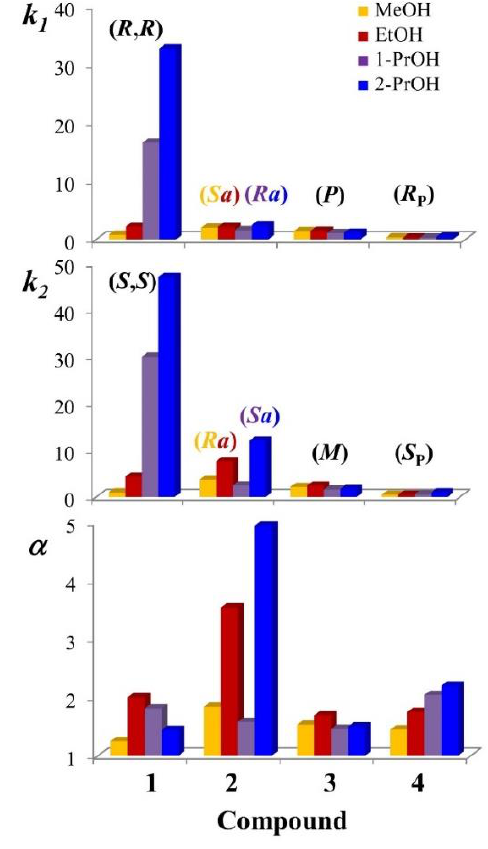
Figure 2. Effect of mobile phase on the retention ( k 1 and k 2 ) and enantioseparation ( α ) factors of 1 – 4 . Chromatographic conditions: column, Chiralpak AD-3 (100 mm × 4.6 mm, 3 µ m); flow rate, 1 mL/min; temperature, 25 °C; detection, UV and CD at 241 nm. 2-PrOH: 2-propanol; 1-PrOH: 1-